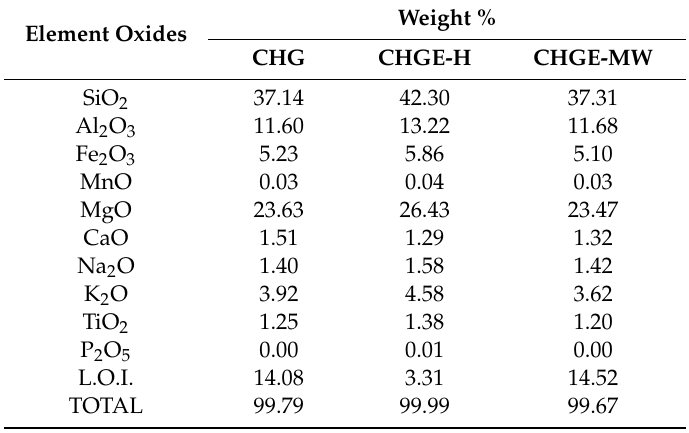
Table 1. Major elements percentages expressed in